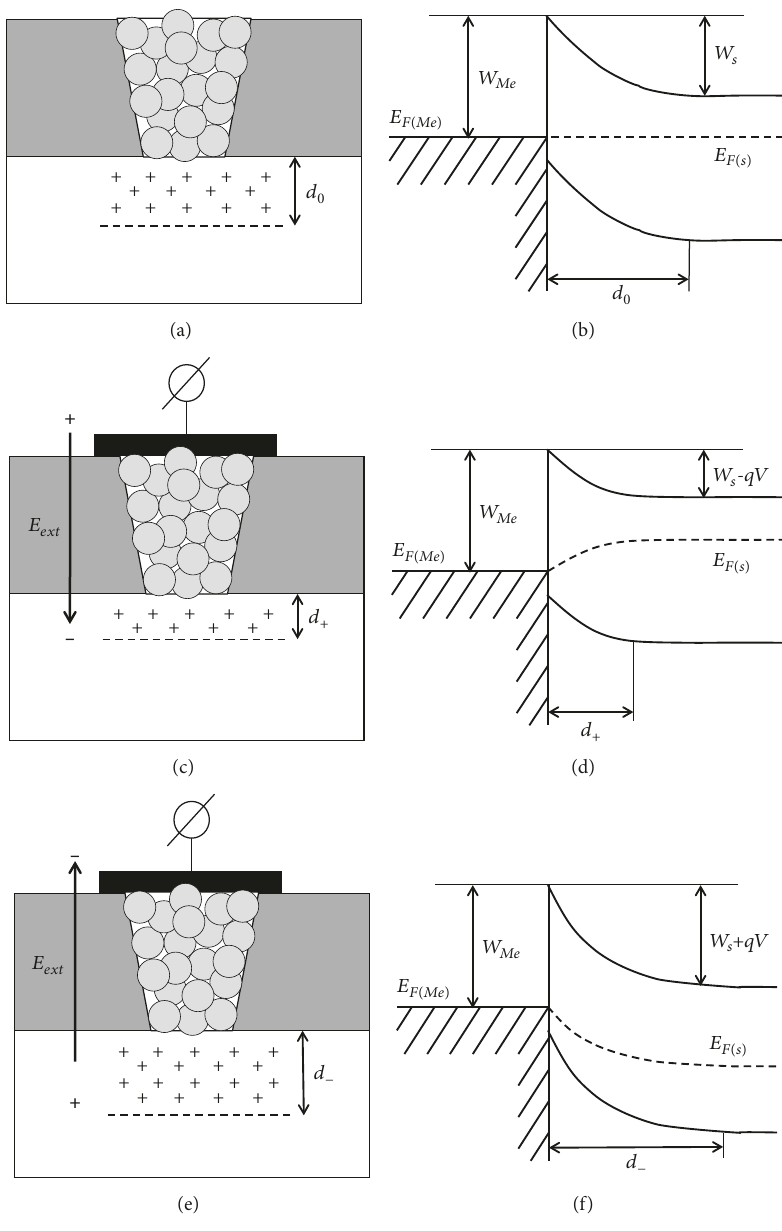
Figure 3: Schematic representation of electron-depleted region formation in contact area of metallic particles with 𝑛 -Si in absence of an external electric field (a), at 𝐸 ext with “+” sign on metal side (c), with a “–” sign (e); scheme for band structure formation in contact region at 𝐸 𝐸 > 0 (d), 𝐸 < 0 ext = 0 (b), ext ext